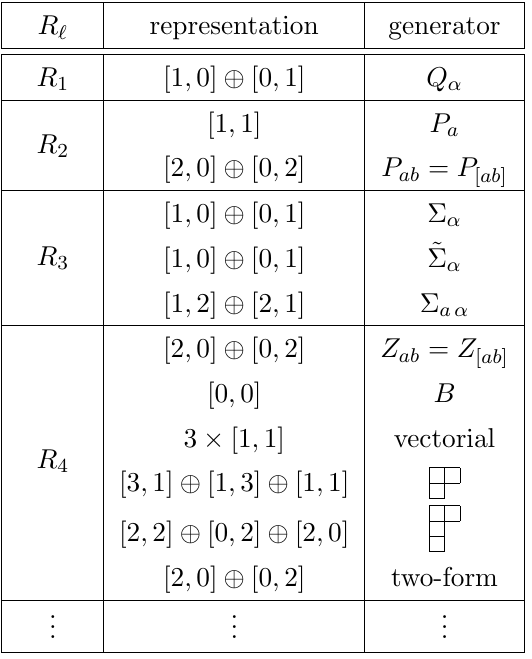
The free Lie superalgebra f ( Q ) in D = 4 space-time dimensions for a single four- component spinor generator Q (cid:11) . We have grouped representations together that form a nice rep- resentation of so (1 ; 3). All tensor-spinors are gamma traceless, but we retain the tensor traces, meaning that for example the (cid:12)rst non-trivial Young tableau in R 4 represents a tensor structure Y ab;c where one can still take the Lorentz trace as discussed in footnote 2; this corresponds to